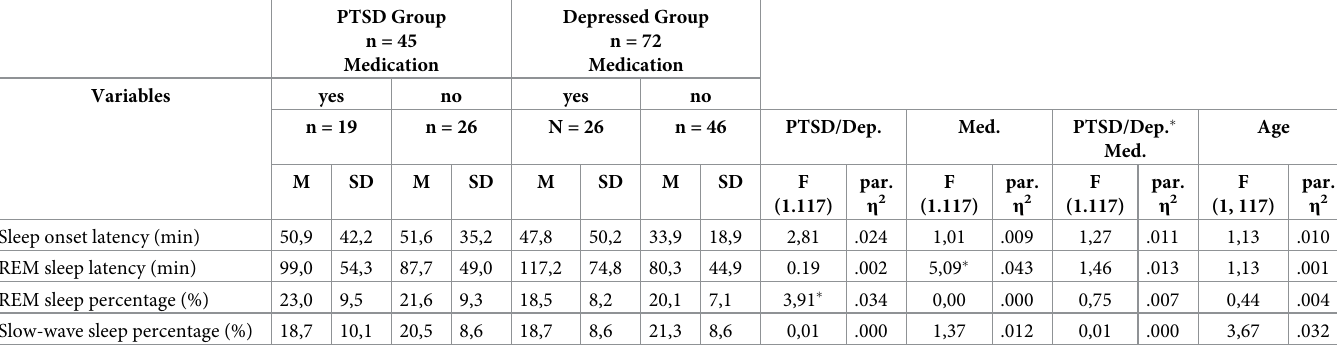
Table 2. Effects of group membership, medication and interaction of group and medication on the sleep physiological variables (sleep onset latency, REM sleep latency, slow-wave sleep percentage of sleep period time, REM sleep percentage of sleep period